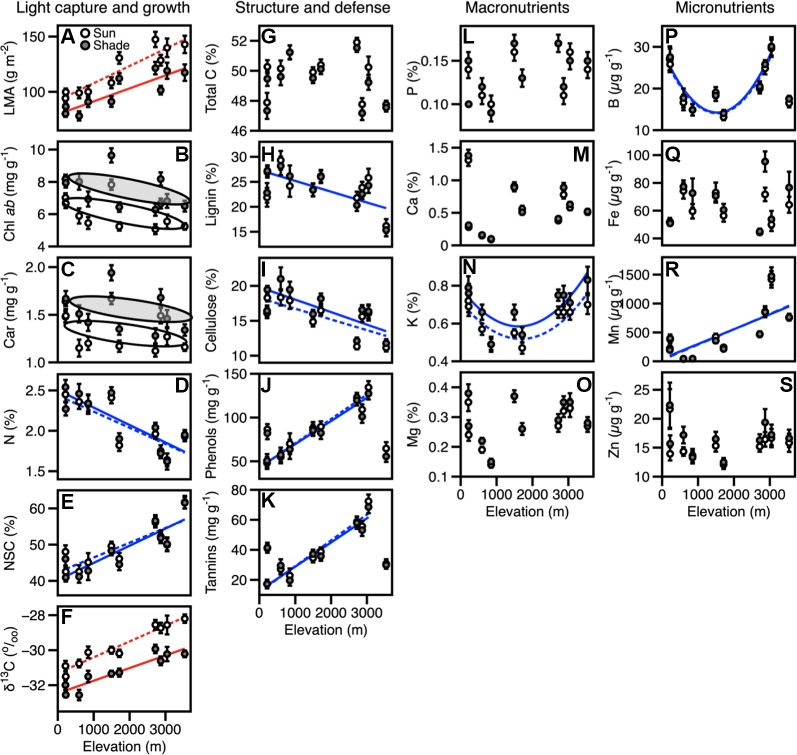
Site mean values for foliar traits, expressed on a mass-basis in sun (open circles) and shade (closed circles) along an elevation gradient are shown. (A–S) Variation in foliar traits corresponding to sun-shade canopy positions along an Andes-Amazon elevation gradient in Peru. Error bars represent standard errors. Solid and dotted lines connect trait values across the sites for shade and sun leaves respectively. Red lines indicate significant relationships with elevation. Blue lines show significant trends with elevation for the values of sun and shade when these trait values did not differ between canopy positions. Grey and white ovals indicate significant differences in traits between sun and shade leaves that are not correlated with elevation. Number of individuals per site are given in Table S1. Equations for trait-elevation relationships are given in Table S4.